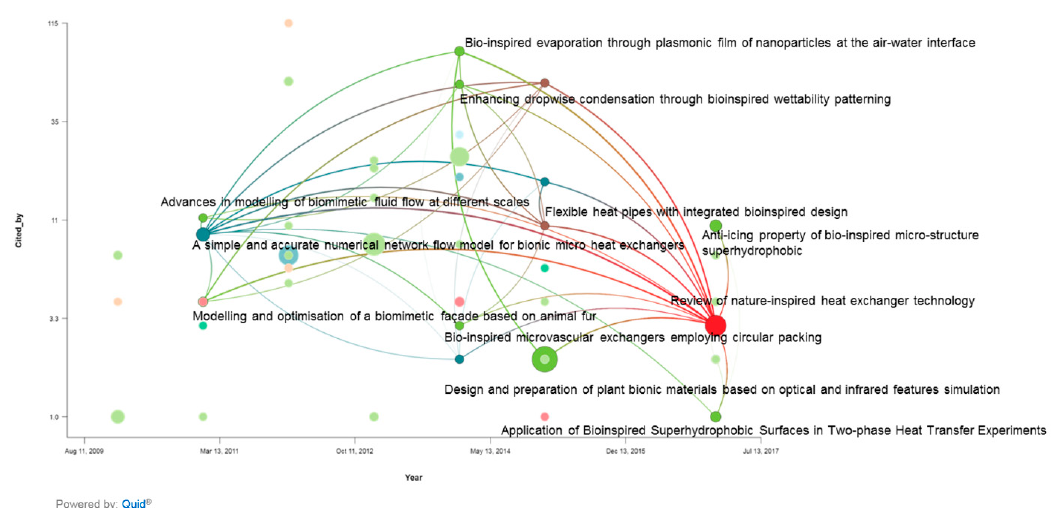
Figure 9. Recent publications in the field of heat transfer showing connections between articles either through references, common topics or shared authorship.